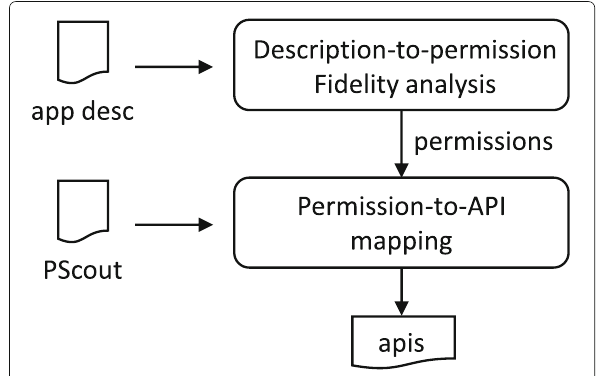
Fig. 3 The learning process of